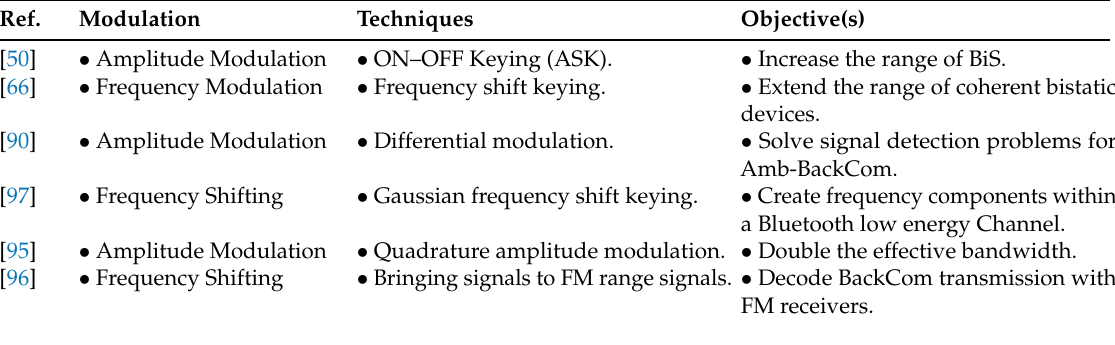
Table 7. Summary of modulation techniques for